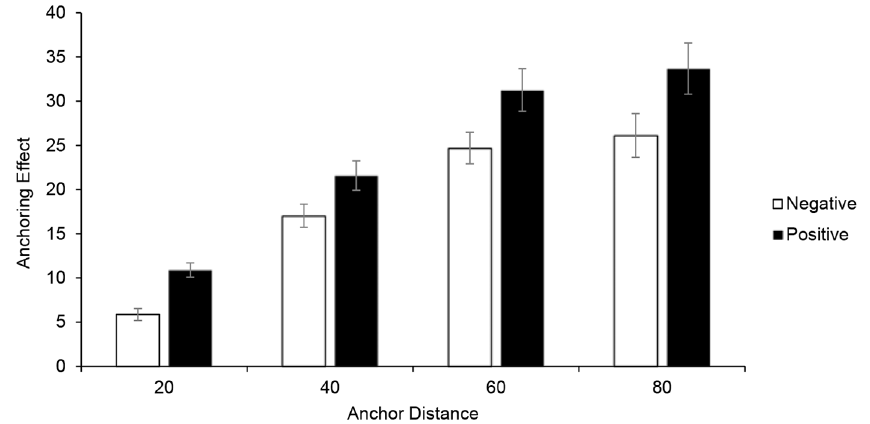
Figure 1. Mean anchoring effect and 95% CI error bars for each experimental